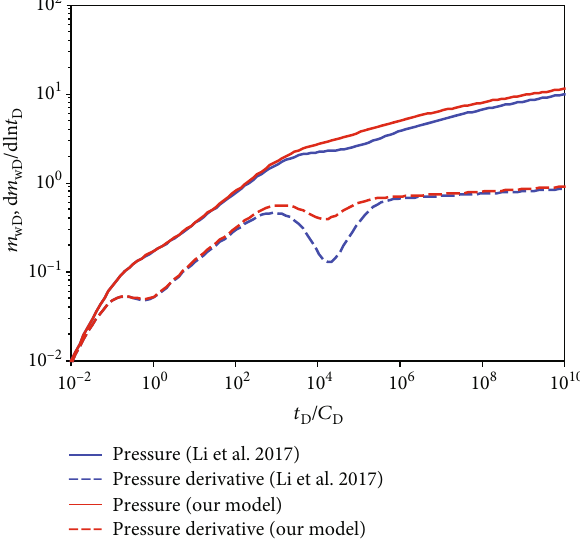
Figure 5: Comparison of the results of the proposed model with that of Li et al.